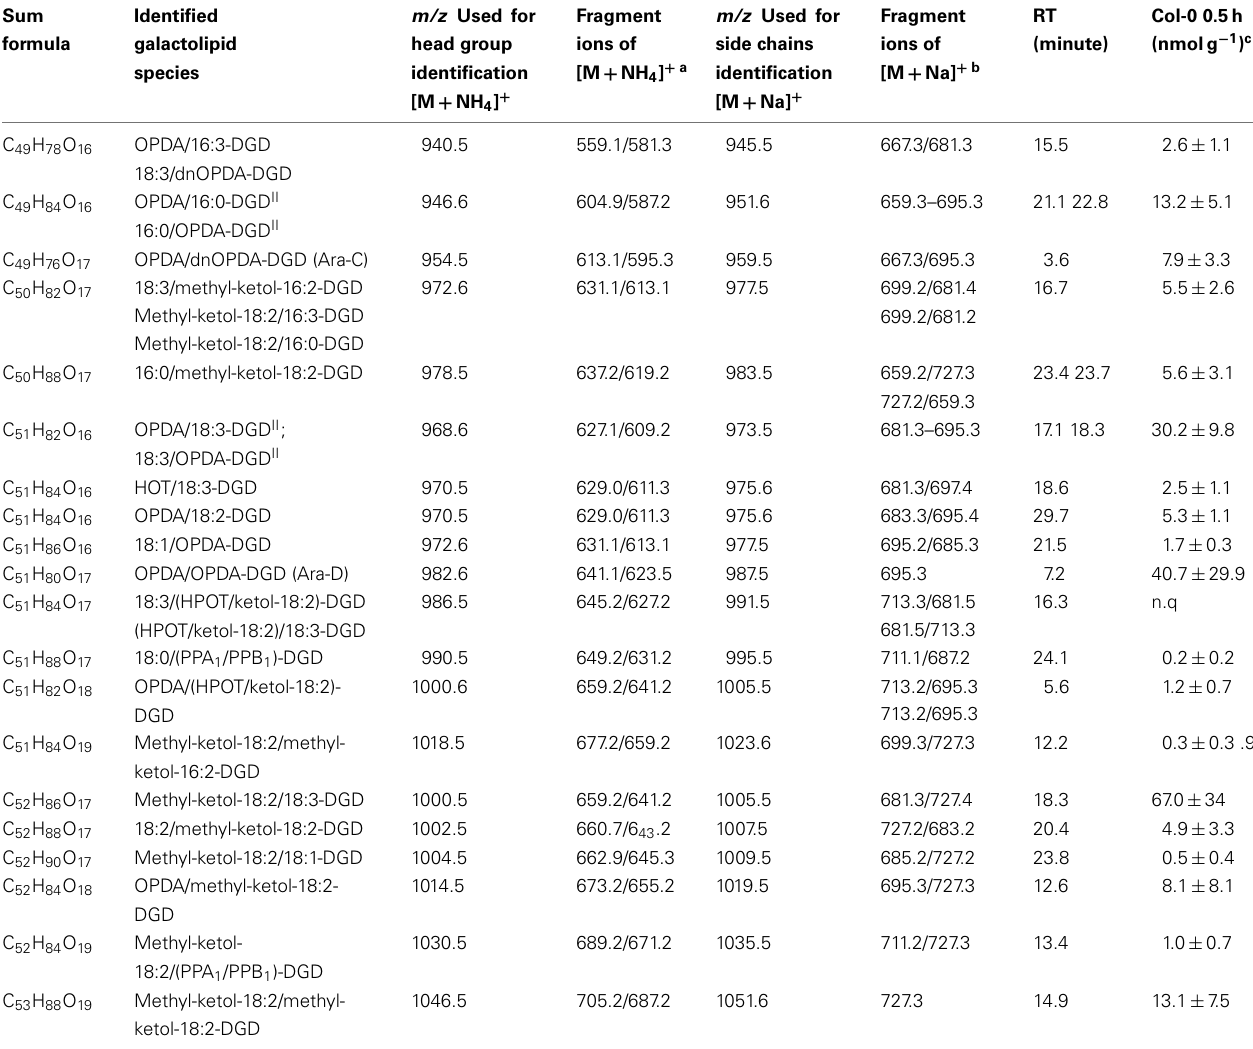
TableA4 | Oxidized DGD species identified in wounded A. thaliana leaves.